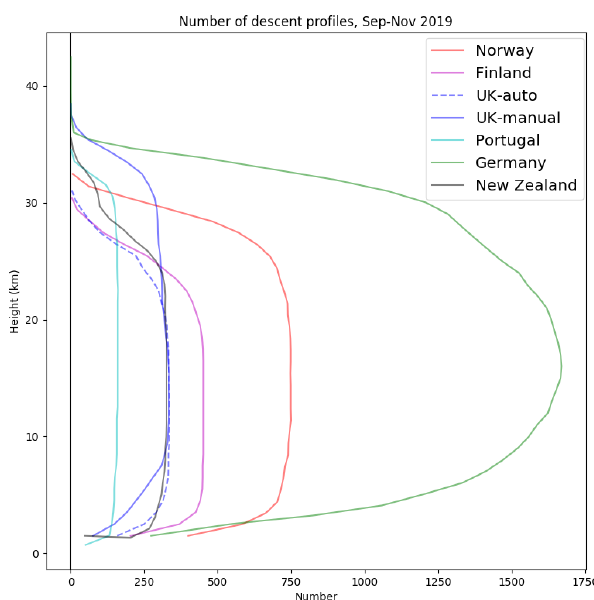
Figure 2. The number of RS41 descent reports by height and coun- try for September–November